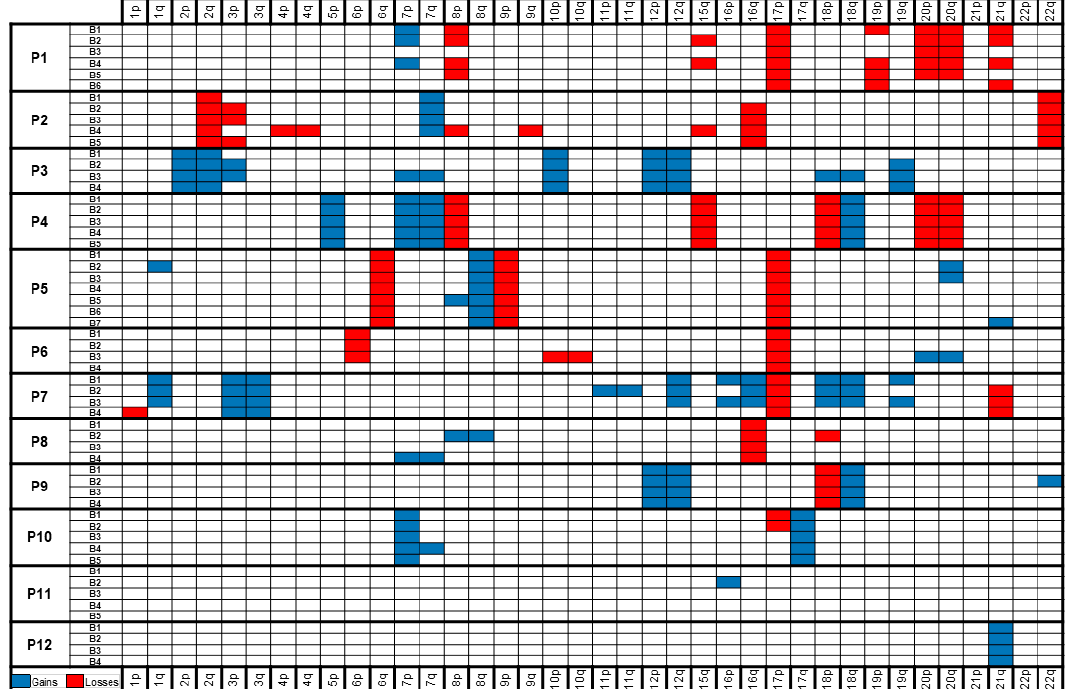
Figure 3. The copy number variants for all the biopsies (B) of each patient. Gains are shown in blue and losses in red. A representative example of patient 5 is shown in Figure 4. All seven biopsies of this patient share a complex karyotype including a deletion 17p. However, biopsy 1, 2, and 4 (TU 1,2,4) as well as the bone marrow biopsy show additional alterations suggesting both clonal evolution over time as well as spatial heterogeneity in one lymphoma sample. The phylogenetic trees of the other patients are shown in the appendix (Figure S1). Figure 4. Seven biopsies of patient 5 and the detected copy number variants (CNVs). A biopsy of a single lymph node at primary diagnosis was available from this patient, which is shown at the top